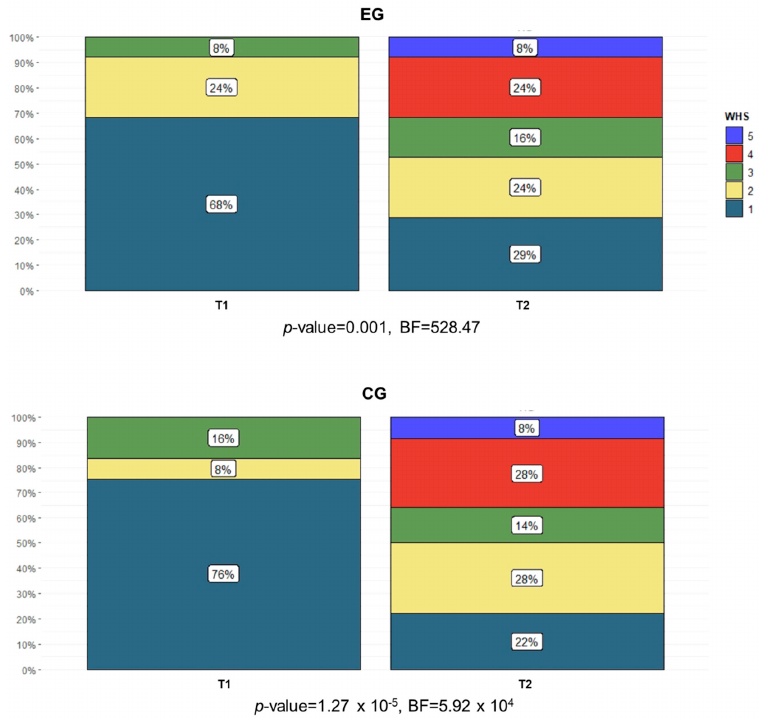
Figure 8. Percentage of subjects in each WHS category (1 = physiological gait; 2 = indoor gait with limitations; 3 = indoor gait without limitations; 4 = community ambulation with major limitations; 5 = community ambulation with some limitations; 6 = community ambulation without limitations) in both the EG and the CG at T1 and T2.